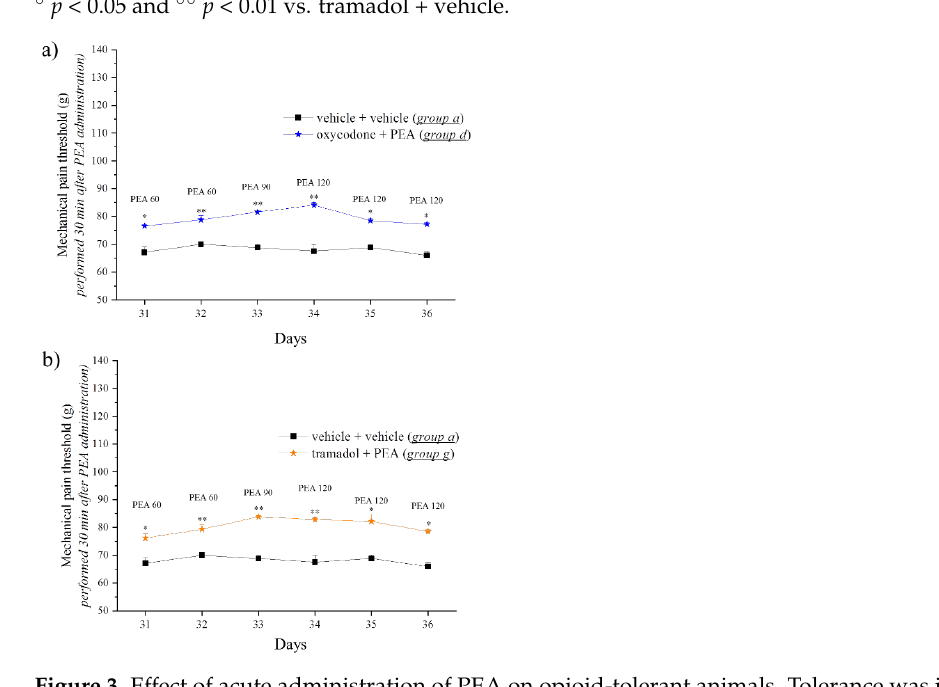
Figure 3. Effect of acute administration of PEA on opioid-tolerant animals. Tolerance was induced by treating rats with ( a ) oxycodone (0.5 mg kg −1 s.c.; Group d) or ( b ) tramadol (20 mg kg −1 s.c.; Group by treating rats with ( a ) oxycodone (0.5 mg kg − 1 s.c.; Group d) or ( b ) tramadol (20 mg kg − 1 s.c.; g) from Day 1 to Day 29. Pre-emptive PEA (30 mg kg −1 ) was orally administered daily (in the even- Group g) from Day 1 to Day 29. Pre-emptive PEA (30 mg kg − 1 ) was orally administered daily (in ing) for the duration of the experiment (Days − 8 to 29) in Groups d and g. On Day 31, when tolerance